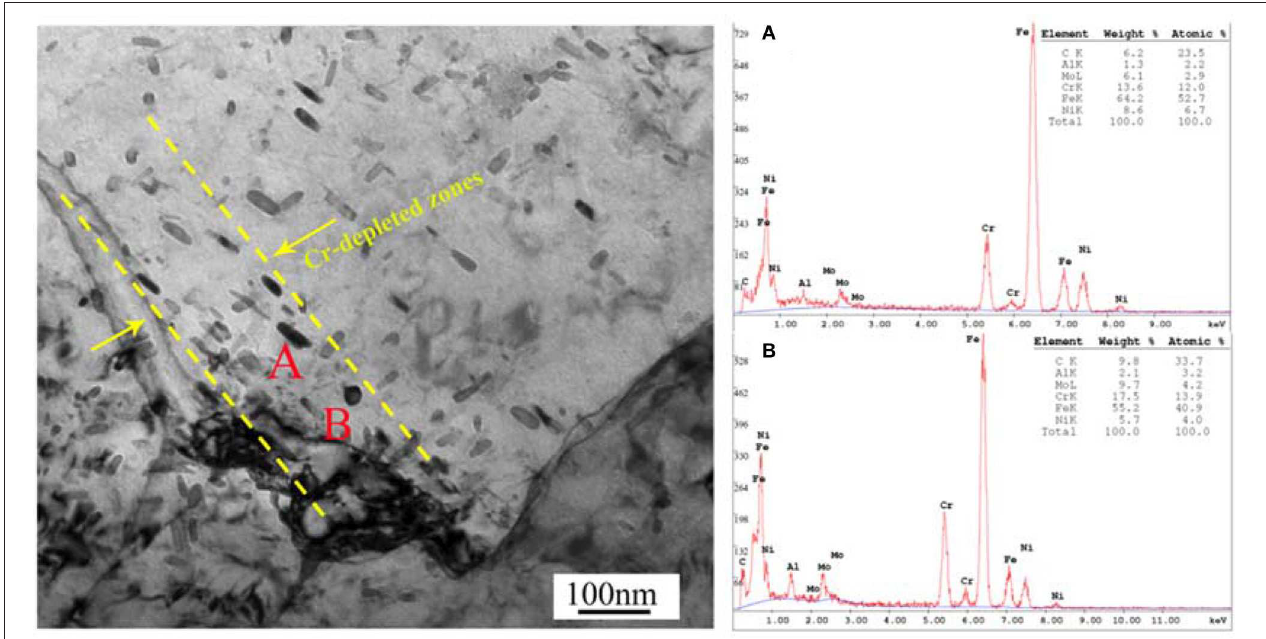
FIGURE 2 | Bright field TEM image showing the morphologies and chemical composition of the precipitates (A,B) .